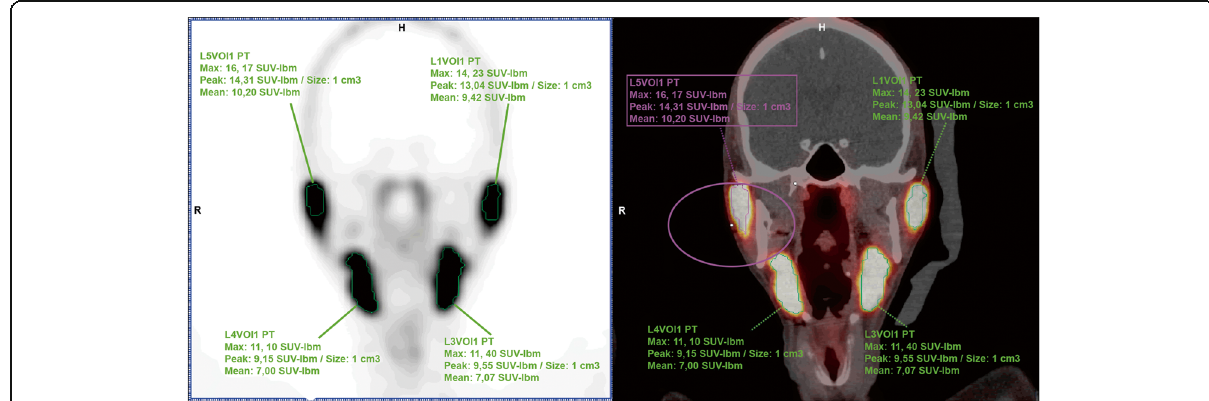
Fig. 2 Measurements on PSMA uptake in both parotid glands in a patient who was scanned with a left-sided icepack. Differences in PSMA uptake were observed, when comparing the cooled (left) side to the non-cooled (right)